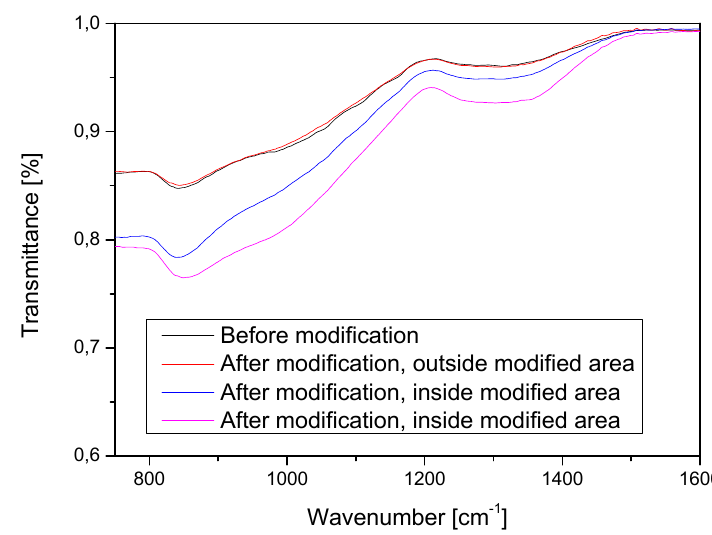
Figure 6. The Fourier-transform infrared (FTIR) spectra recorded before and after the plasma modification inside and outside of modified area. The change, which represents a reaction between free radicals and the surface, can be observed only after the modification, inside of the discharge area.